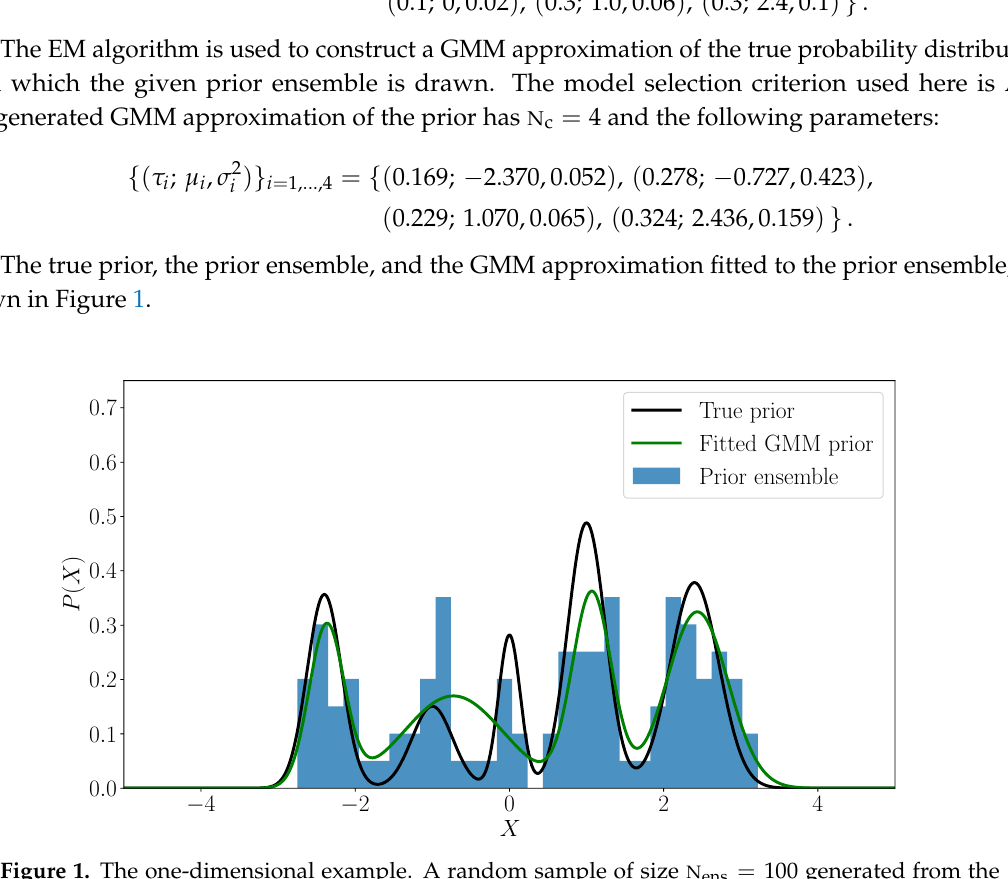
Figure 1. The one-dimensional example. A random sample of size N ens = 100 generated from the “true” GMM prior with parameters given by (26), and a GMM constructed by EM algorithm with AIC model selection